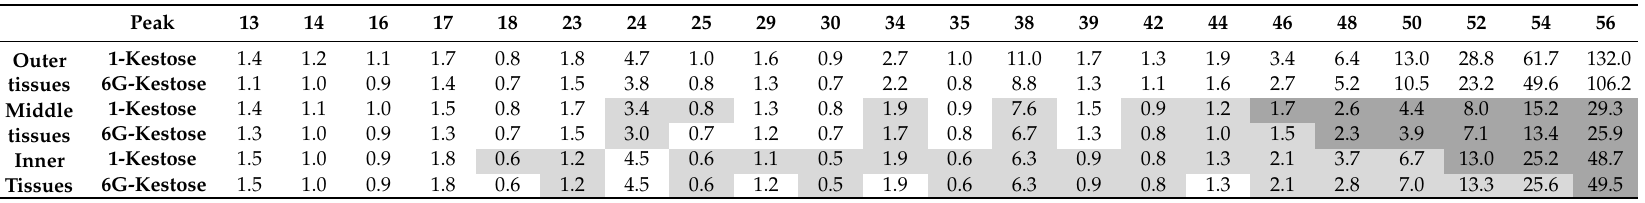
Table 2. Ratio of 1-kestose and 6G-kestose relative to peaks for fructans with higher degree of polymerization. Peak numbers refer to annotations in Table 1. Ratios were calculated from mean integrated peak area shown in Figure 3 and Supplementary Table S1. Values for middle and inner tissues, which had decreased by at least 20% (light gray) or at least 50% (dark gray) relative to outer tissues, are